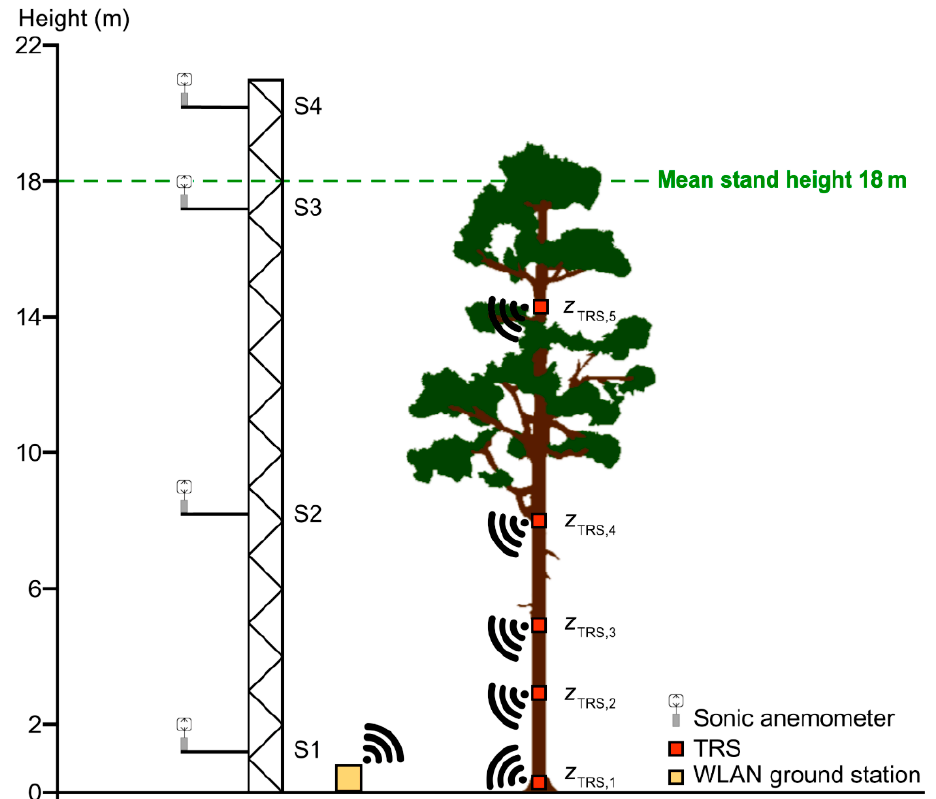
Figure 2. System used to measure airflow and stem tilt. Four ultrasonic anemometers (S1 to S4) mounted to a slender scaffold tower measured the horizontal and vertical wind vector components at 2 m, 9 m, 18 m, and 21 m. Tilt of the sample trees’ stems under natural wind conditions and during pulling tests was measured in different configurations with the Tree Response Sensor (TRS) [40] at heights z TRS,1 = 0.1 m, z TRS,2 = 1/7 H , z TRS,3 = 5 m, z TRS,4 = 3/7 H , and z TRS,5 = 5/7 H , H is the tree height.